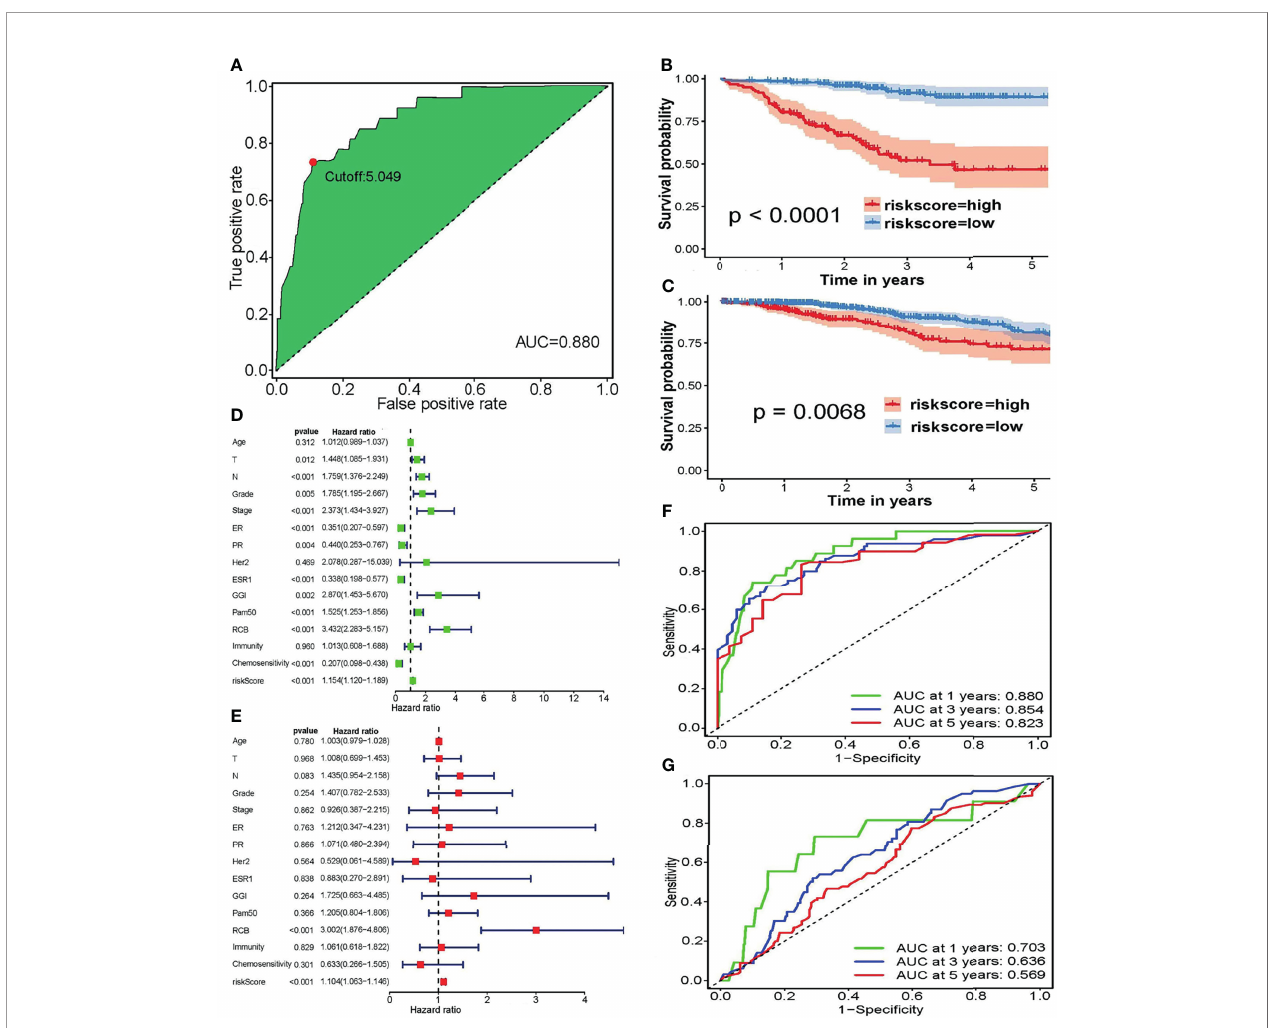
FIGURE 5 | (A) The optimal cutoff points in the ROC curve with the maximum AUC. (B, C) The survival curves to estimate the difference in the survival time between the high-risk and low-risk groupings in the (B) training and (C) validation sets. (D, E) Forest plots of the training set using (D) univariate and (E) multivariate independent prognostic analyses. (F, G) To evaluate the accuracy of our risk model, 1-, 3-, and 5-year ROC curves were plotted in the (F) GEO and (G) TCGA datasets.